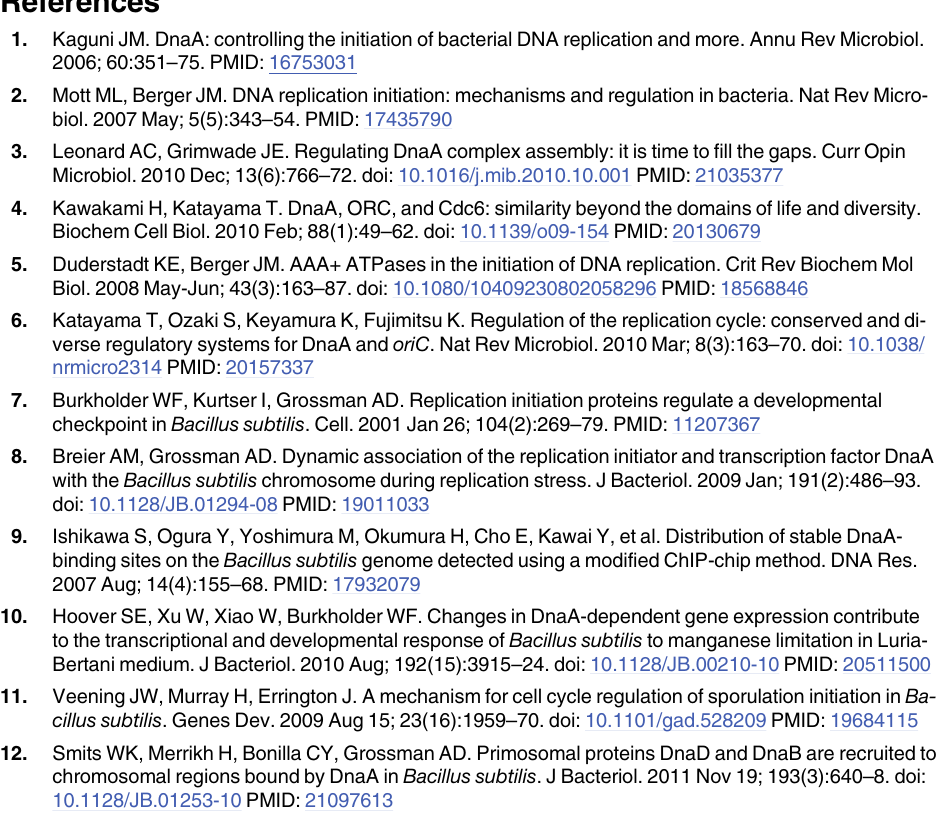
S4 Table. Predicted DnaA boxes in all 269 binding regions. All DnaA boxes drawn in S1 Fig are presented. Peak numbers are the same as in S1 Table and correspond to the panel numbers in S1 Fig. Start coordinates correspond to the genome sequence of strain AG1839 [29]. P values are from RSAT [49]. The distance from the center nucleotide of the DnaA box to the peak sum- mit (found in S1 Table) is shown. S5 Table. Primers used for